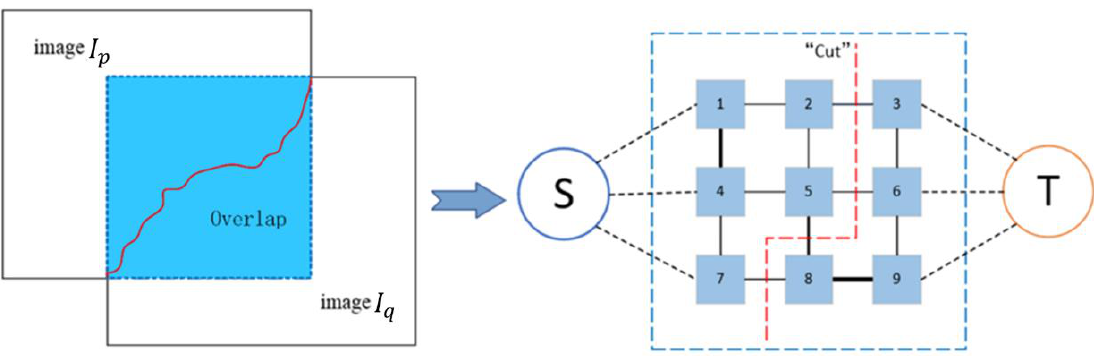
Figure 3. Illustration of optimal seamline via graph cut. We denote each image element as a node and the energy cost between pixels as the weight of an edge. The “cut” marked next to the red dotted line denotes the min-cut.